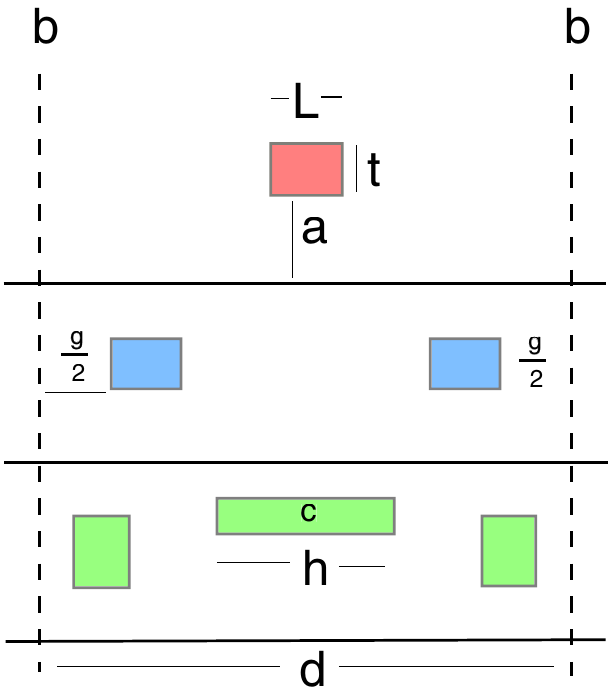
FIG. 2. (Color) Basic configuration of lattices with one, two, and three coils per